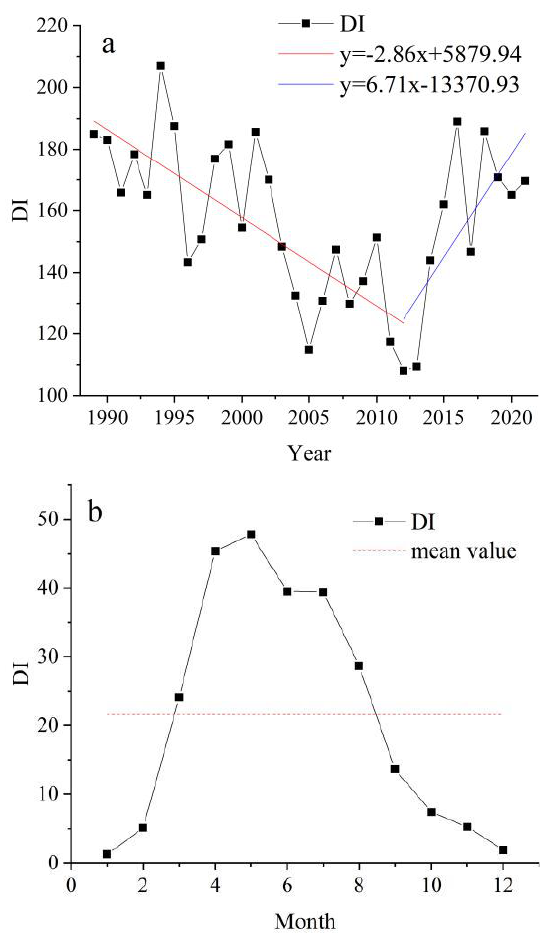
Figure 5. Interannual and monthly variation in DI in Tarim Basin, ( a ) Interannual variation; ( b ) monthly variation.